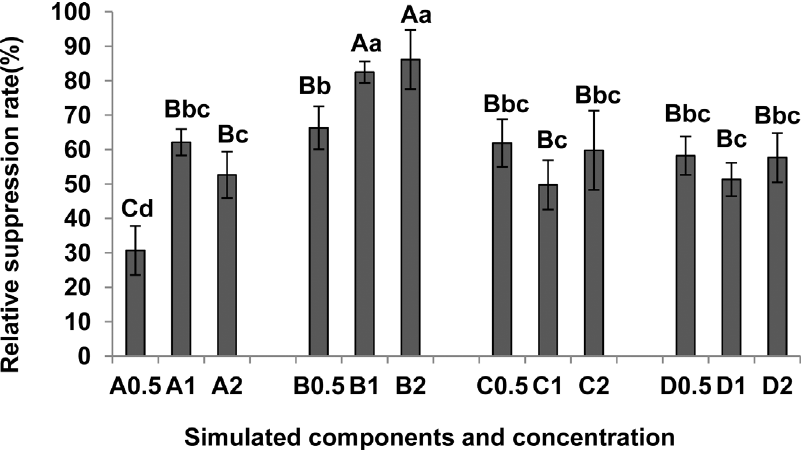
Fig 4. Effects of simulated components on relative suppression of M . incognita egg hatch. A, 2,6-Di- tert-butyl-p-cresol; B, L-ascorbyl-2,6-dipalmitate; C, dibutyl phthalate; D, dimethyl phthalate; 0.5,0.5 mmol (cid:1) L -1 ; 1,1 mmol (cid:1) L -1 ; 2,2 mmol (cid:1) L -1 . Total number of J2 in each treatment (1.0% ethanol as control) was calculated at 8d after starting the assay. Relative suppression rate (%) = (number of J2 in control — number of J2 in treatment) / number of J2 in control × 100. Each bar represents the mean, and error bars indicate standard error of the mean from three replicates. Capital and lower case letters indicate significant group differences at the levels of 0.01 and 0.05, respectively.